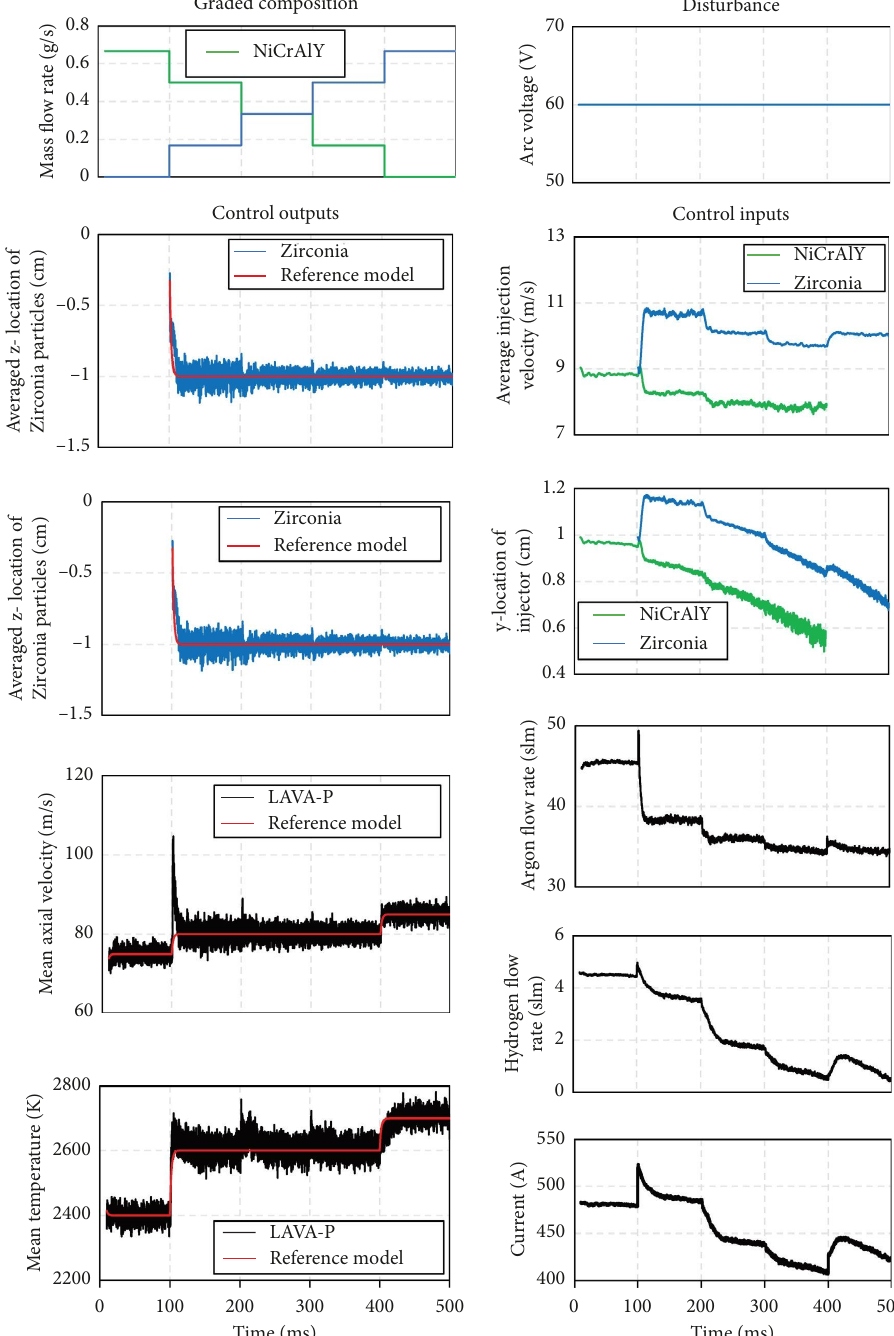
Figure 12: For the desired graded composition of the coating exhibited in row 1 in column 1 under the disturbance shown in row 1 in column 2, the adaptive tracking performance of the measured outputs to the desired responses of the reference model (in red) is depicted from row 2 to row 5 in column 1 using the adaptive process controller by adjusting the control inputs shown from row 2 to row 6 in column